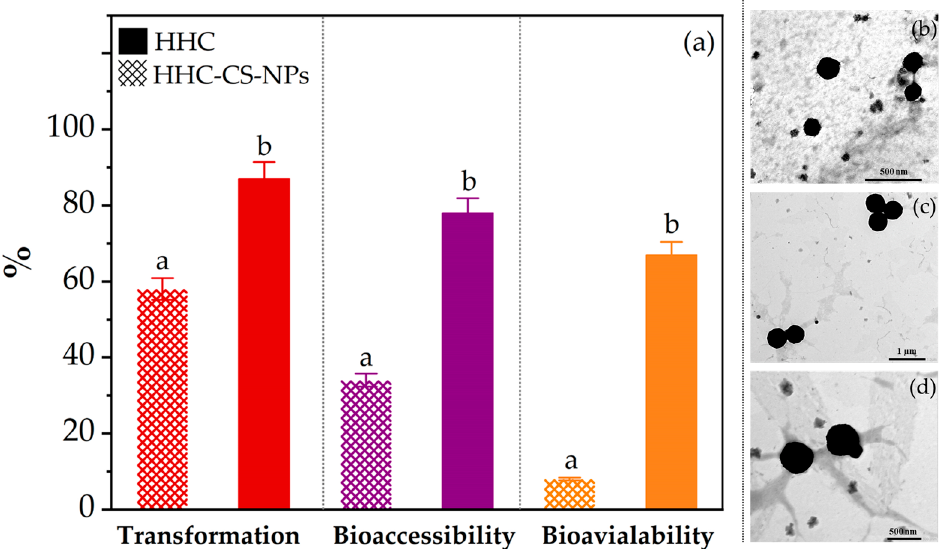
Figure 5. ( a ) Transformation, bioaccessibility, and in vitro bioavailability of HHC in free form (HHC solution) or in HHC-CS-NPs after passing through the simulated GI model ( n = 3); TEM images of HHC-CS-NPs after passing through simulated GI models: ( b ) oral phase (at 25,000 × magnification), ( c ) gastric phase (at 8000× magnification), and ( d ) intestinal phase (at 15,000× magnification). Different letters indicate significant differences at p < 0.05.